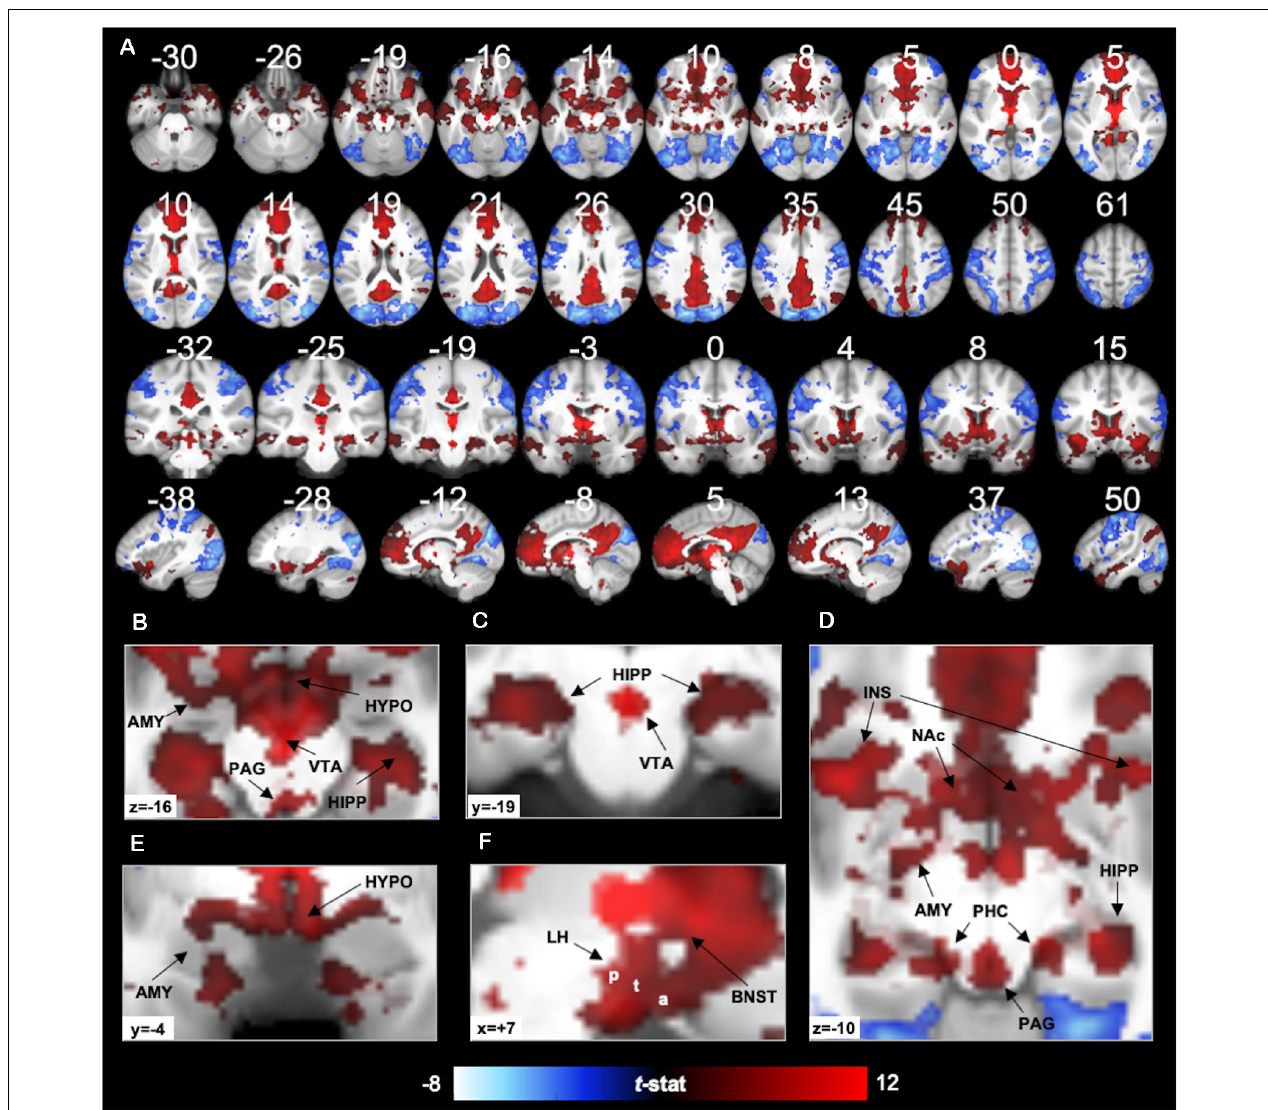
FIGURE 2 | 7T PVT functional connectivity. Positive (red) and negative (blue) functional connectivity of the PVT controlling for average signal from the rest of the thalamus. Results thresholded at p TFCE-FWE < 0.05. Statistical overlays shown on average subject anatomical. (A) Multi-planar views (compare to the 3T results in Figure 7 and Supplementary Figures 9, 10 shown on the same slices). (B) Axial slice highlighting positive FC with the amygdala (AMY), hippocampus (HIPP), Hypothalamus (HYPO), Periaqueductal Gray Area (PAG), and Ventral Tegmental Area (VTA). (C) Coronal slice showing positive FC with the bilateral hippocampus and the VTA. (D) Axial slice showing positive FC with AMY, HIPP, insula (INS), nucleus accumbens (NAc), PAG, and parahippocampal cortex (PHC). (E) Coronal slice showing positive FC with the AMY and HYPO. (F) Sagittal slice showing lateral HYPO (a = anterior, t = tuberal, p = posterior) and Bed Nucleus of the Stria Terminalis (BNST) positive FC. See Supplementary Figure 6 for further illustrations of positive FC with BNST, HYPO, PAG, and VTA.